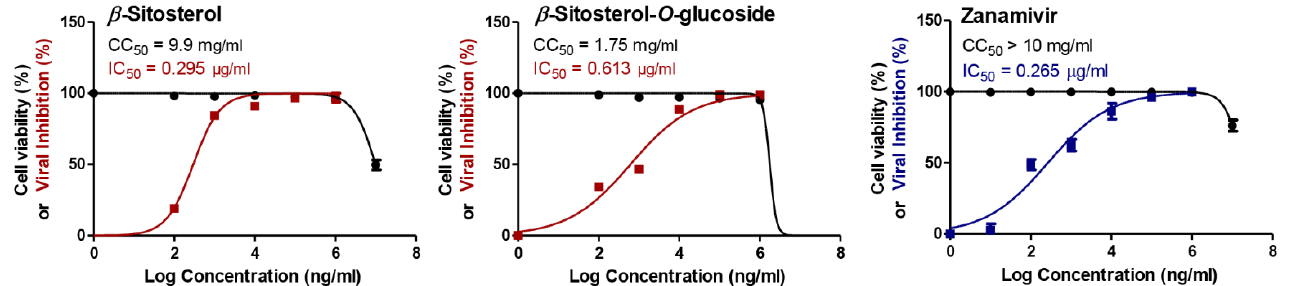
Figure 2. The cytotoxicity as expressed in CC 50 (half-maximal cytotoxic concentration) and the anti- viral potential against A/H5N1 as expressed in IC 50 (half-maximal inhibitory concentration) for the most efficacious steroids ( β -sitosterol and β -sitosterol- O -glucoside). GraphPad Prism 5.01 software was used to analyze the nonlinear regression, while the CC 50 and IC 50 were determined by plotting log inhibitor against normalized response (variable slope).